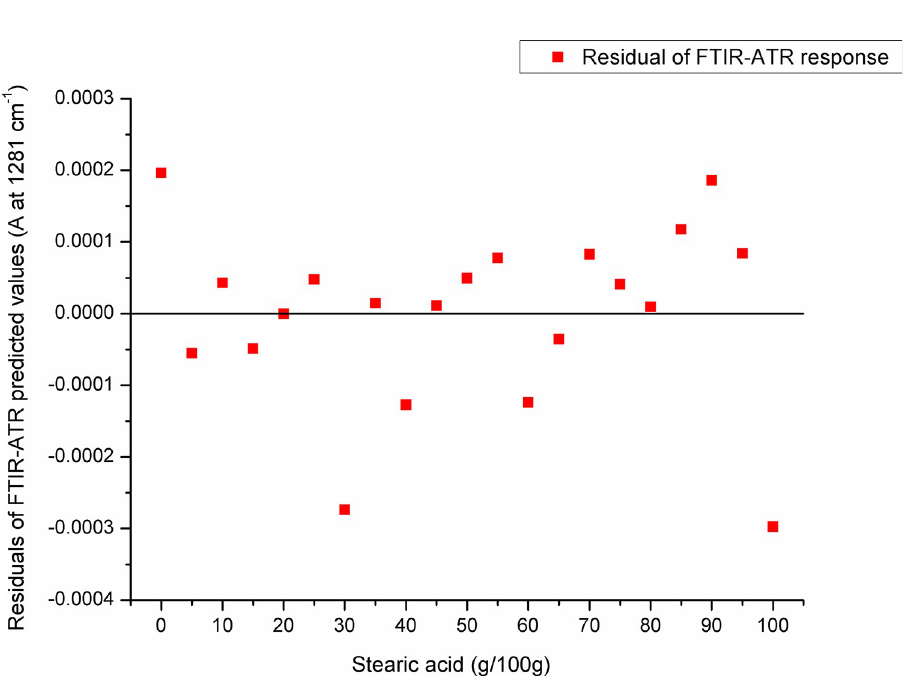
Fig 12. Residuals of FTIR-ATR prediction in the spectral region with an absorption maximum at 1281 cm -1 .